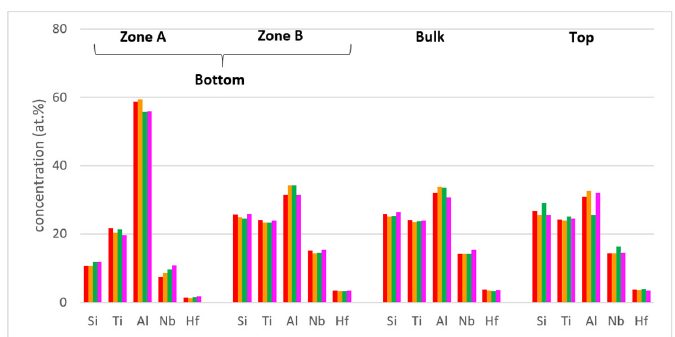
Figure 15. Comparison of the concentrations of elements in the bottom, bulk and top of the alloy Nb 1.3 Si 2.4 Ti 2.4 Al 3.5 Hf 0.4 . Heat treated at 800 °C—red bars (the same as in Figure 5), heat treated at 1200 °C—green bars (the same as in Figure 5), oxidised at 800 °C—orange bars, oxidised at 1200 °C—pink bars.